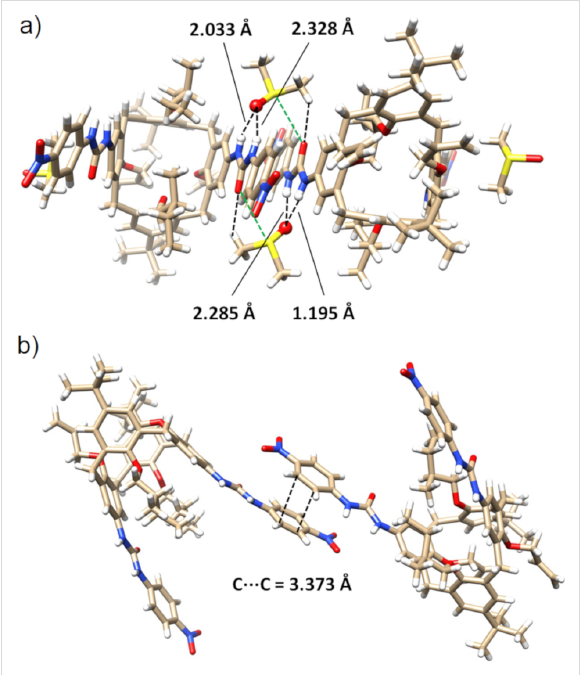
Figure 3: X-ray structure of 7a : (a) Hydrogen bonding interactions (black) in a dimeric motif, chalcogen interactions are shown in green. (b) π – π interactions in the dimeric motif.